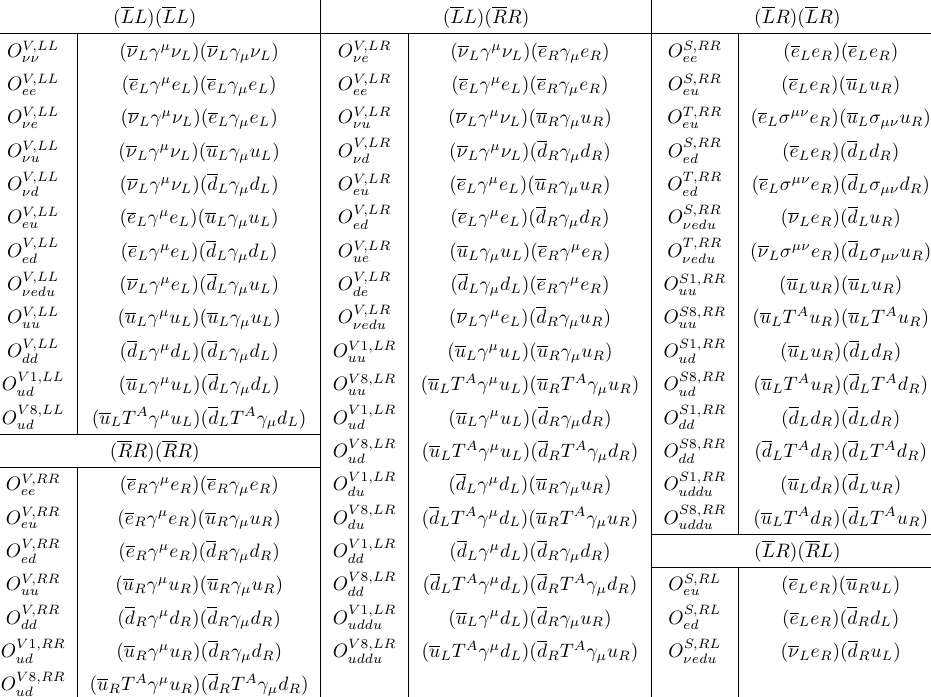
Table 12 . LEFT four-fermion lepton and baryon number conserving